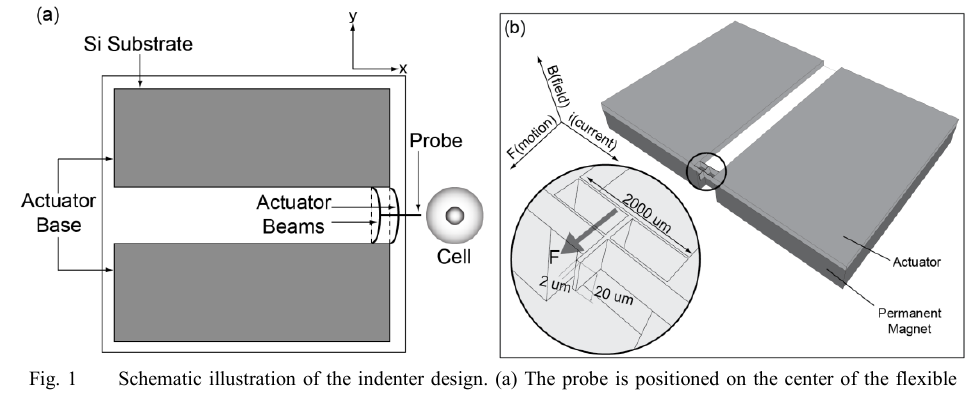
Schematic illustration of the indenter design. (a) The probe is positioned on the center of the flexible actuator beams. As the parallel actuator beams move laterally by Lorentz force, the probe is set to indent a single cell with a known force value. (b) Dimensions of the probe and the actuator